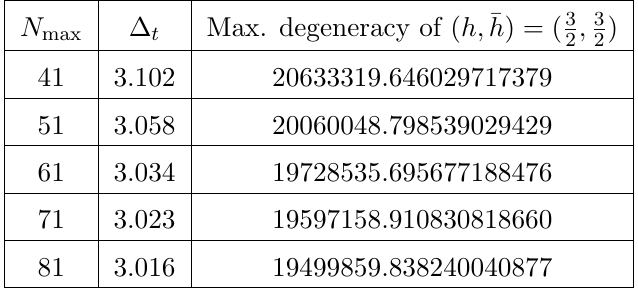
; 3 ) primary, for various N max . 2 2